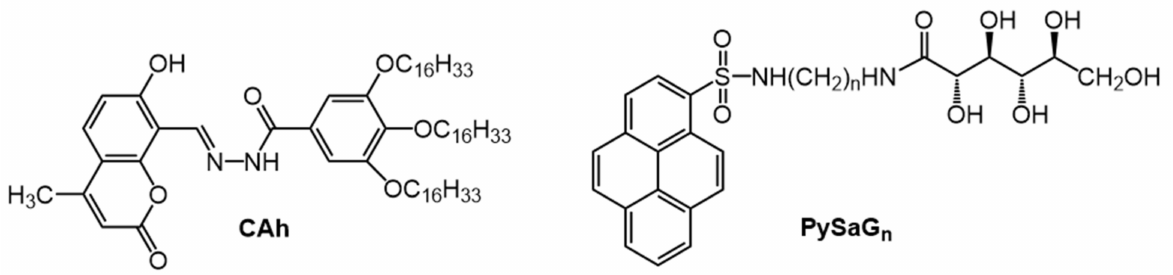
Figure 1. Molecular structures of CAh and PySaG n (where n = 2,3,4,6,7,8) gelators. Fluorescent LMOGs can also be used to probe the gelation process, degree of ag- gregation, and nature of the molecular assembly process within the gel network. In one such study, Yan et al., used gelators comprised of a 1-pyrenyl group with a glucono sub- stituent and diamine spacers of different lengths, PySaG n (Figure 1) [39]. In acetonitrile with excitation at 350 nm, a 10 nm blue shift and lowered intensity of excimeric emis- sion were observed in the gel form ( λ em = 478 nm, 20 ◦ C) of 1.5% PySaG 7 compared to the sol ( λ em = 488 nm, 80 ◦ C) (Figure 2). This change suggests the easier reorientation of pyrenyl groups of PySaG 7 in the sol, facilitating excimer emission. In the gel phase, the more restrictive packing arrangement makes the attainment of the excimer geometry more